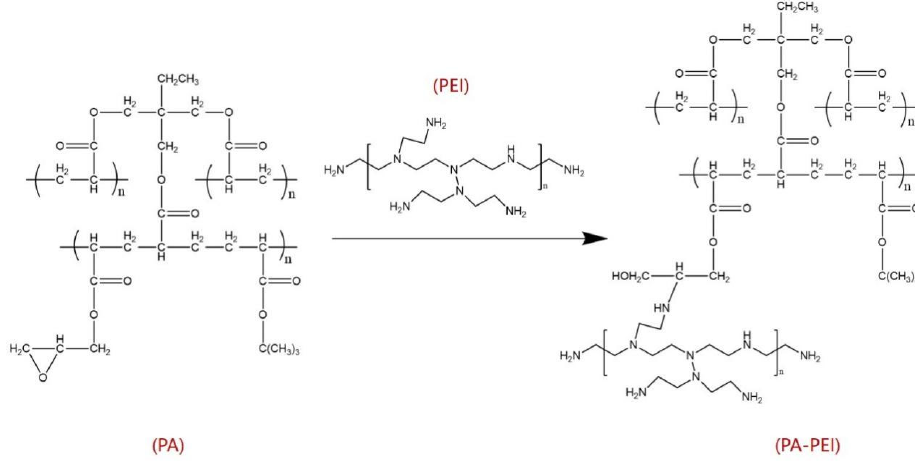
Figure 11. The reaction process of surface modi fi cation of